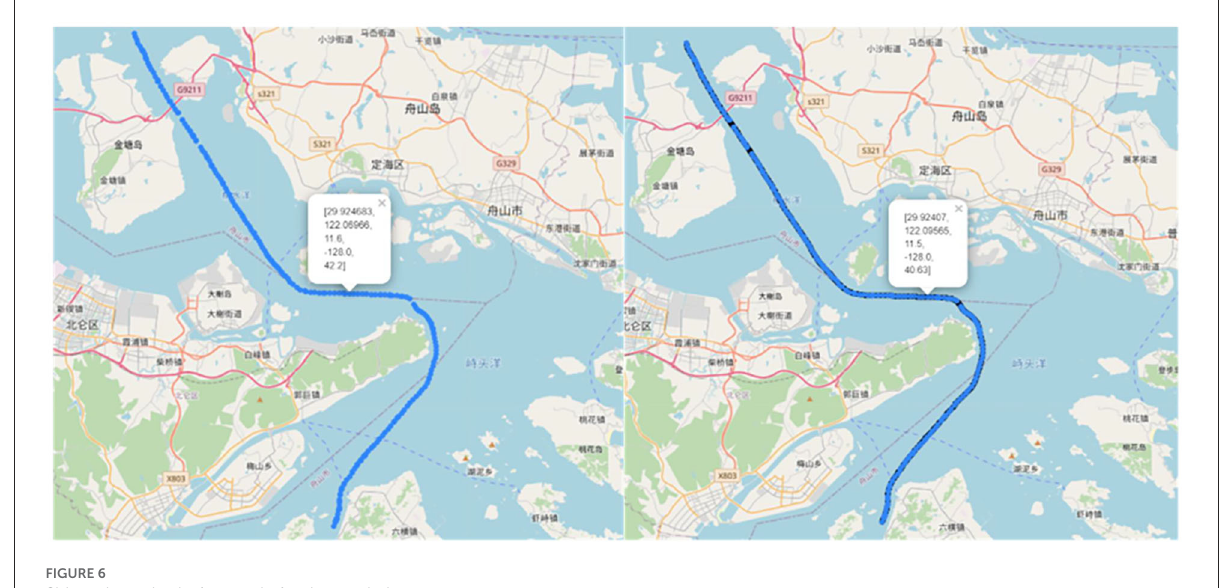
FIGURE6 Ship trajectories before and after